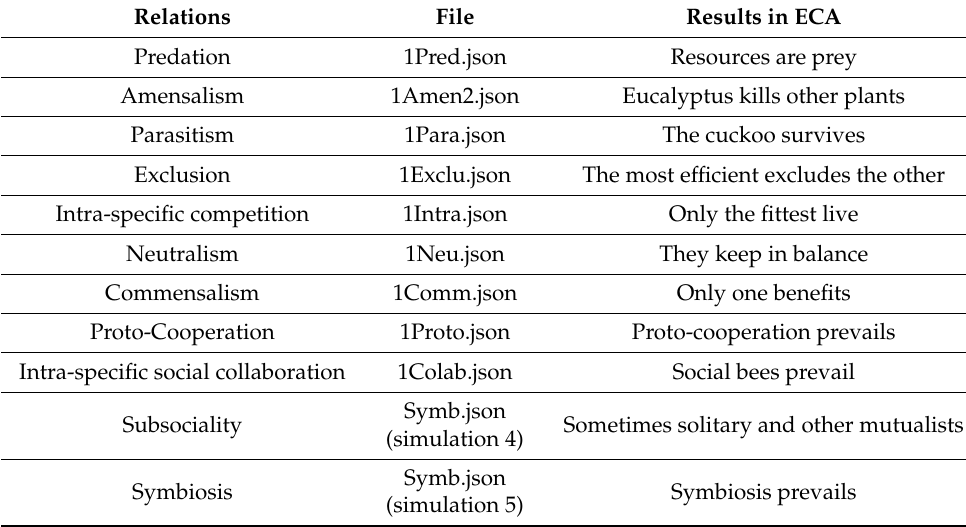
Table 1. Summary of simulations to check social